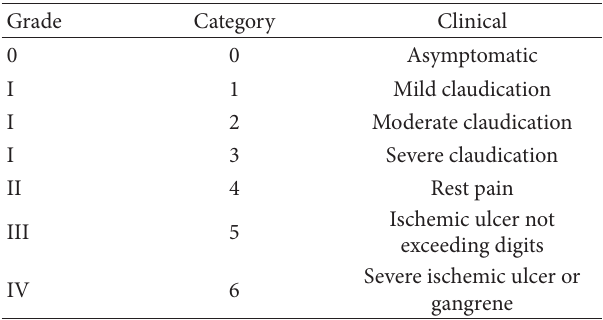
Table 1: Rutherford